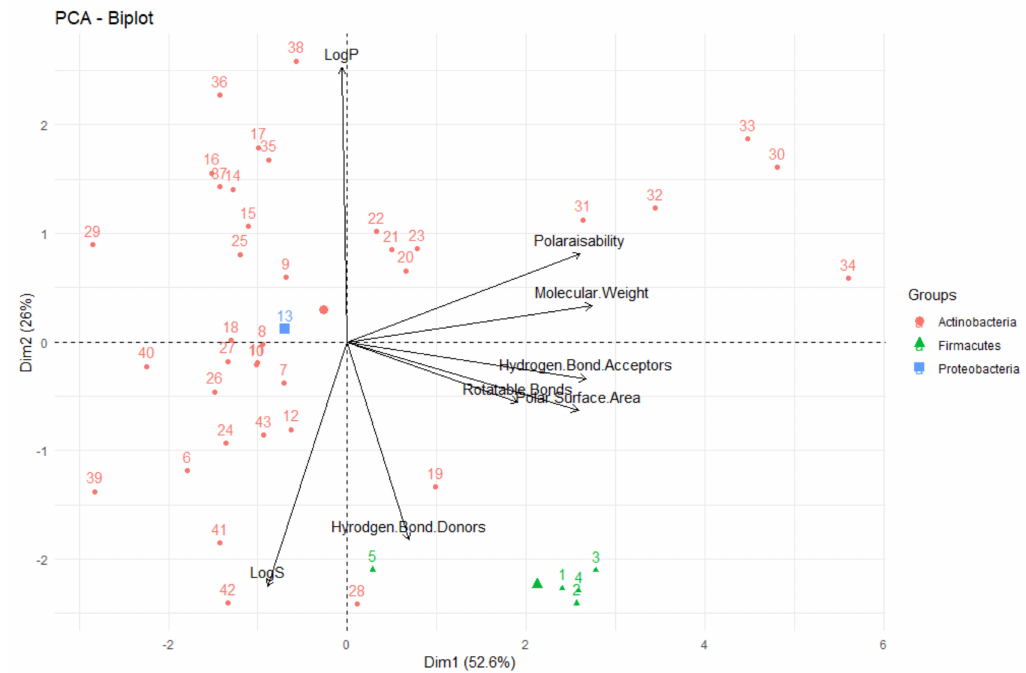
Figure 23. Biplot representing the PCA analysis on the compounds isolated from organisms in the Bacteria Kingdom and their molecular descriptors (PC1 vs. PC2). The arrows represent molecular descriptors and the direction in which they hold influence. Each point represents a molecule.